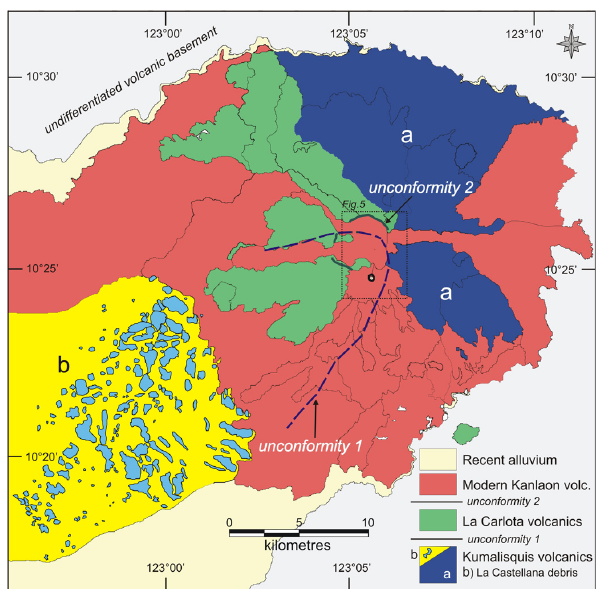
Fig. 4. Simplified geological map of Mt Kanlaon. La Castellana debris avalanche (a) is characterized by numerous and occasionally very large hummocks (up to 1.6km 2 , highlighted in cyan) emerging in the matrix (in yellow); this deposit comes from the dismantling of the pre-existing volcanic edifice (Kumalisquis volcanics, in dark blue).